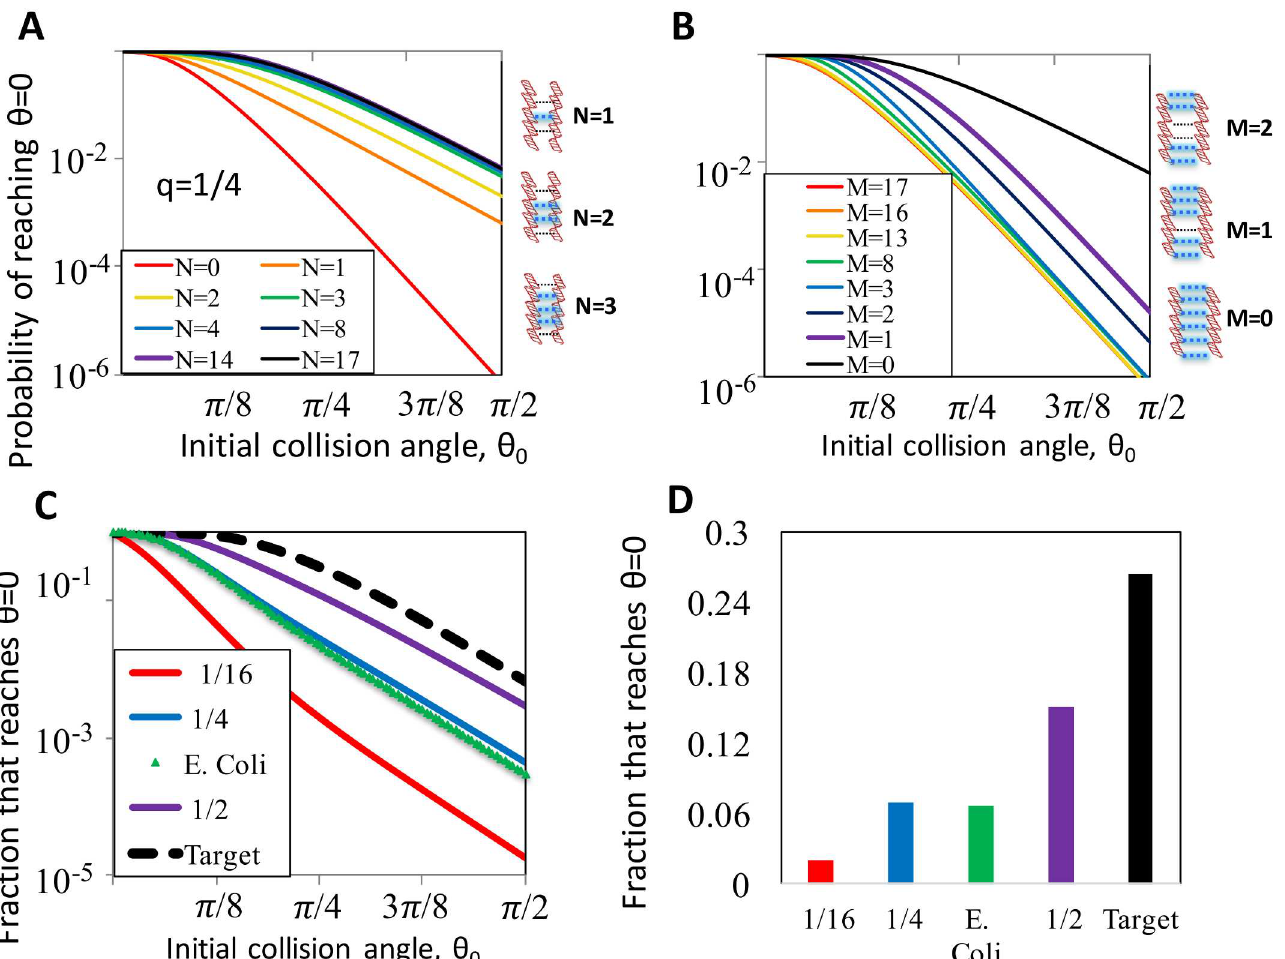
Fig 2. Transition from collision at random angle to parallel alignment. (A) Probabilityof reachinga parallelalignmentas a function of the initial collisionangle θ 0 and the number of continuous matched sites flankingthe collisionpoint N . Here q = 1/4. (B) Same as (A), for sequenceswhere M sites flanking the collisionpoint are the only ones not forced to match. (C) Fraction of attempted pairingsthat reach a parallelalignmentas function of initial collisionangle.Solid lines, mismatched random sequenceswith q = 1/16, 1/4, or 1/2, and with the E. coli genomestatistics. Dashedline, perfectly matchingsequences.(D) The results of (C) averagedover collisionangles up to π /2, assumingcollisionsare uniformlydistributedin 3d.